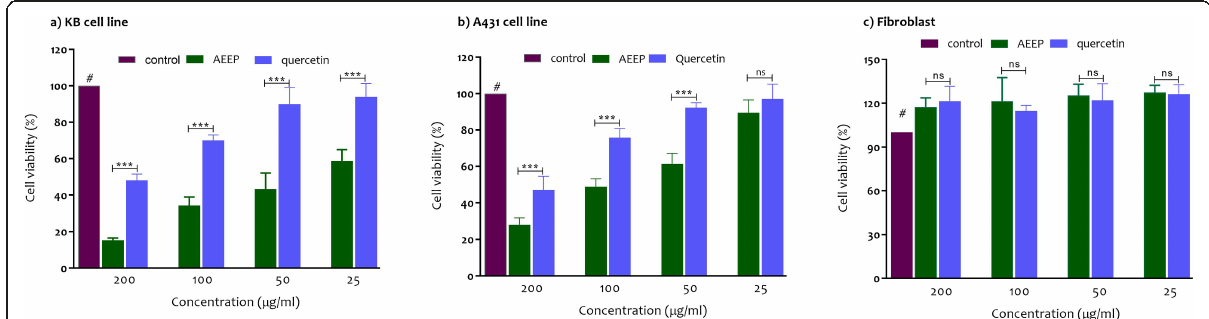
Fig. 4 The percentage of cell viability by MTT exclusion on Mouth epidermoid carcinoma cell (KB) cells ( a ), skin squamous cell carcinoma (A431) cells ( b ) and fibroblast cell lines ( c ). Data are expressed as mean ± SD ( n = 3). *** p < 0.001 and ** p < 0.01 indicated in compare between samples. # There was no significant difference between control with Q 50 μ g/ml and Q 25 μ g/ml in KB, 50 μ g/ml and 25 μ g/ml of AEEP and Q in A431 and the all concentrations of AEEP and Q in fibroblast cell lines ( p <